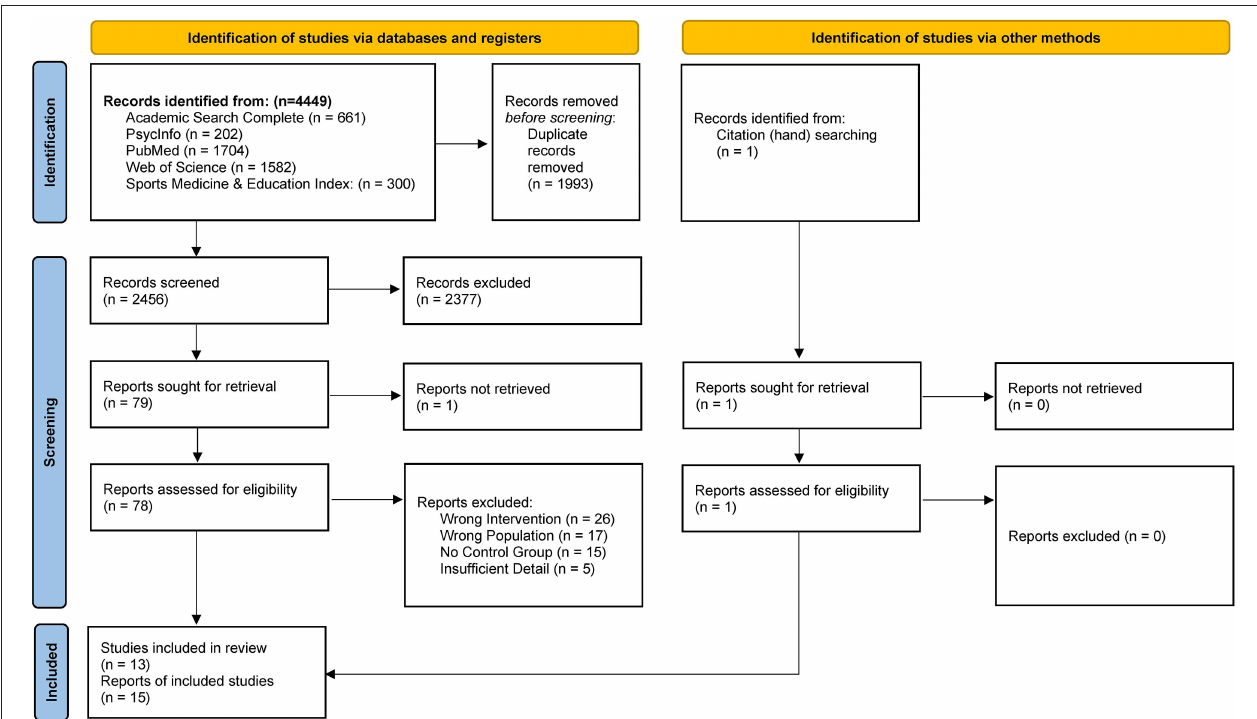
FIGURE 1 | PRISMA Flow Diagram of study selection